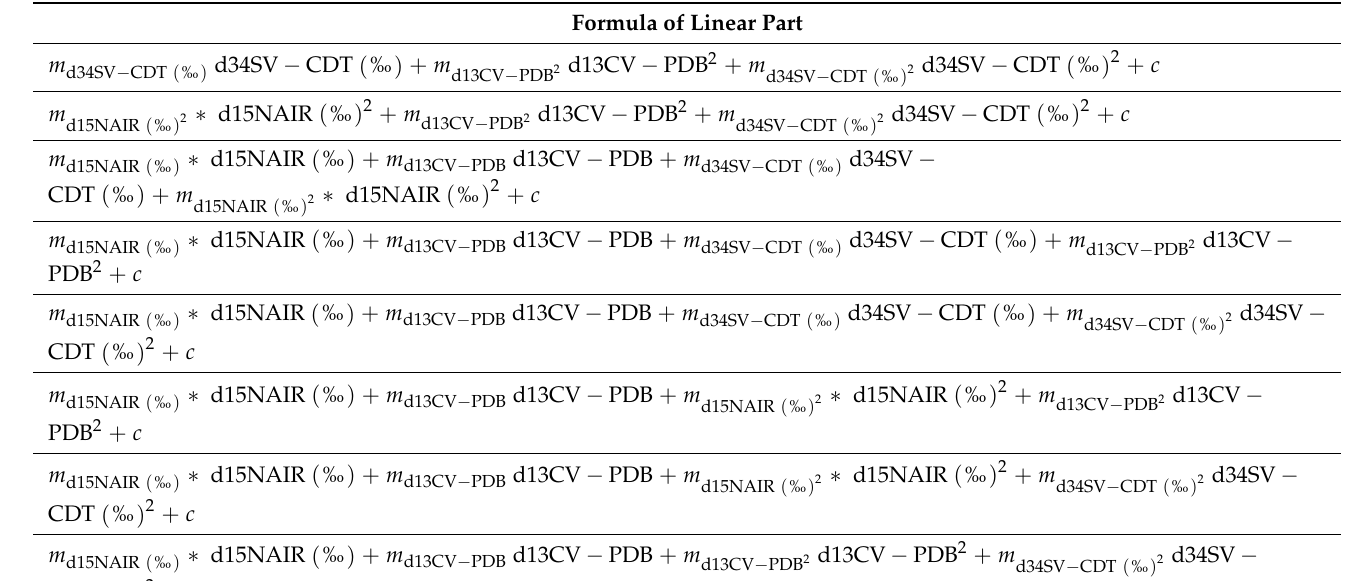
Formula of Linear